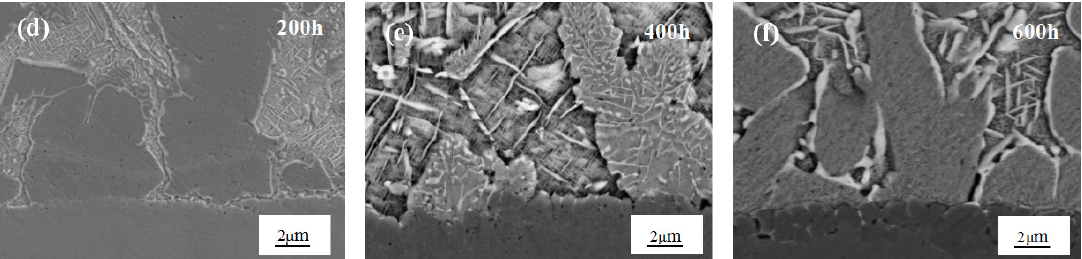
Figure 3. Interfacial microstructure of the Ag16.5CuZnSn-xGa-yCe brazed joints after aging treatment: ( a – c ) Ag16.5CuZnSn-0.15Ce, ( d – f ) Ag16.5CuZnSn-2Ga-0.15Ce.